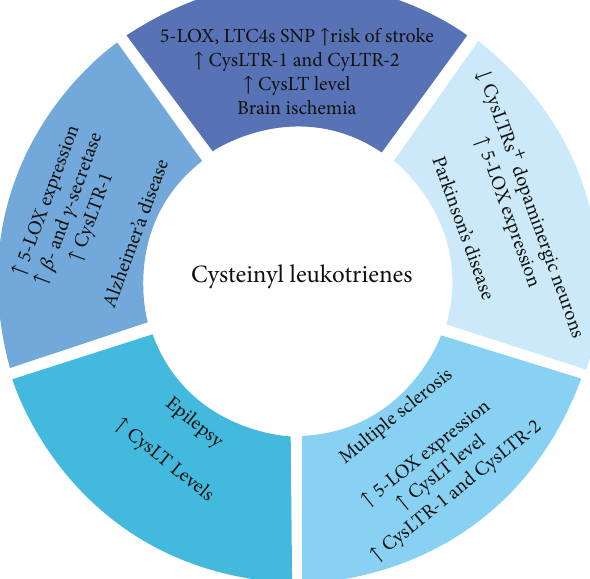
Figure 1: CysLTs in neurodegenerative diseases. The circle shows the changes of the CysLT pathway components grouped for the di ff erent neurodegenerative diseases and observed in human patients and in in vitro/in vivo